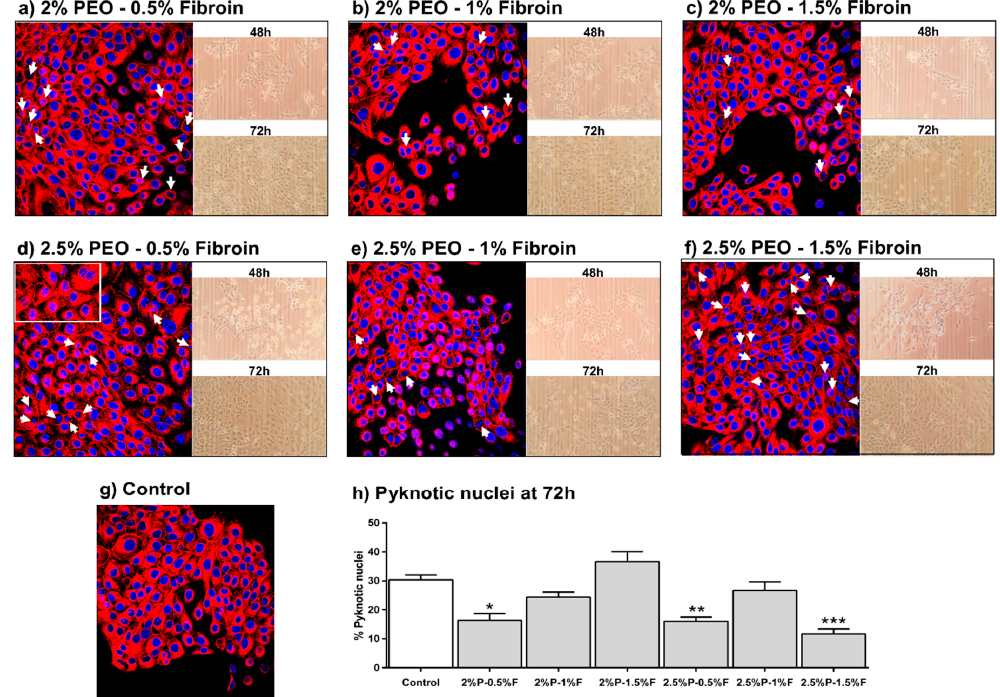
Figure 5. HaCaT cells seeded on PEO–fibroin electrospun mats after 72 h. ( a – f ) Fluorescence staining of nucleus (blue), f-actin of cytoskeleton (red), and phase contrast photographs; ( h ) % pyknotic nuclei quantification at 72 h. Results are expressed as the mean ± standard deviation of triplicates. p -value less than 0.05 (* p < 0.05, ** p < 0.01, and *** p < 0.001) indicates statistically significant difference by one-way ANOVA and Tukey’s test.